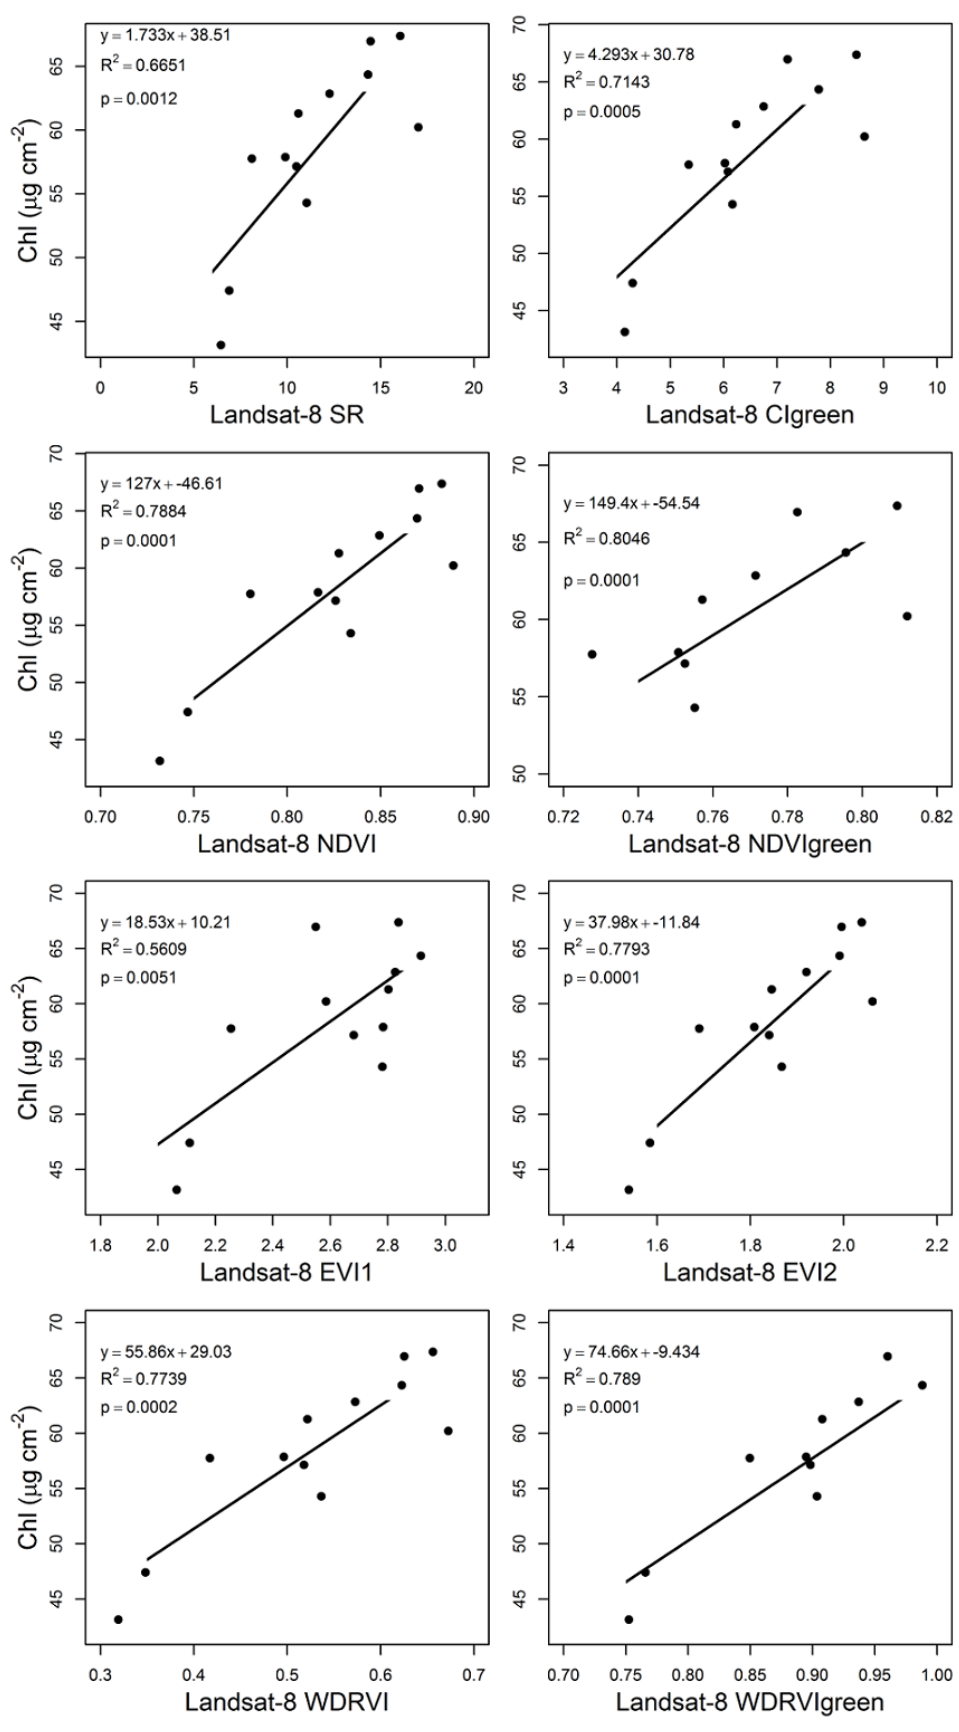
Figure 7. Correlations between Landsat 8 VIs and CC at ESU